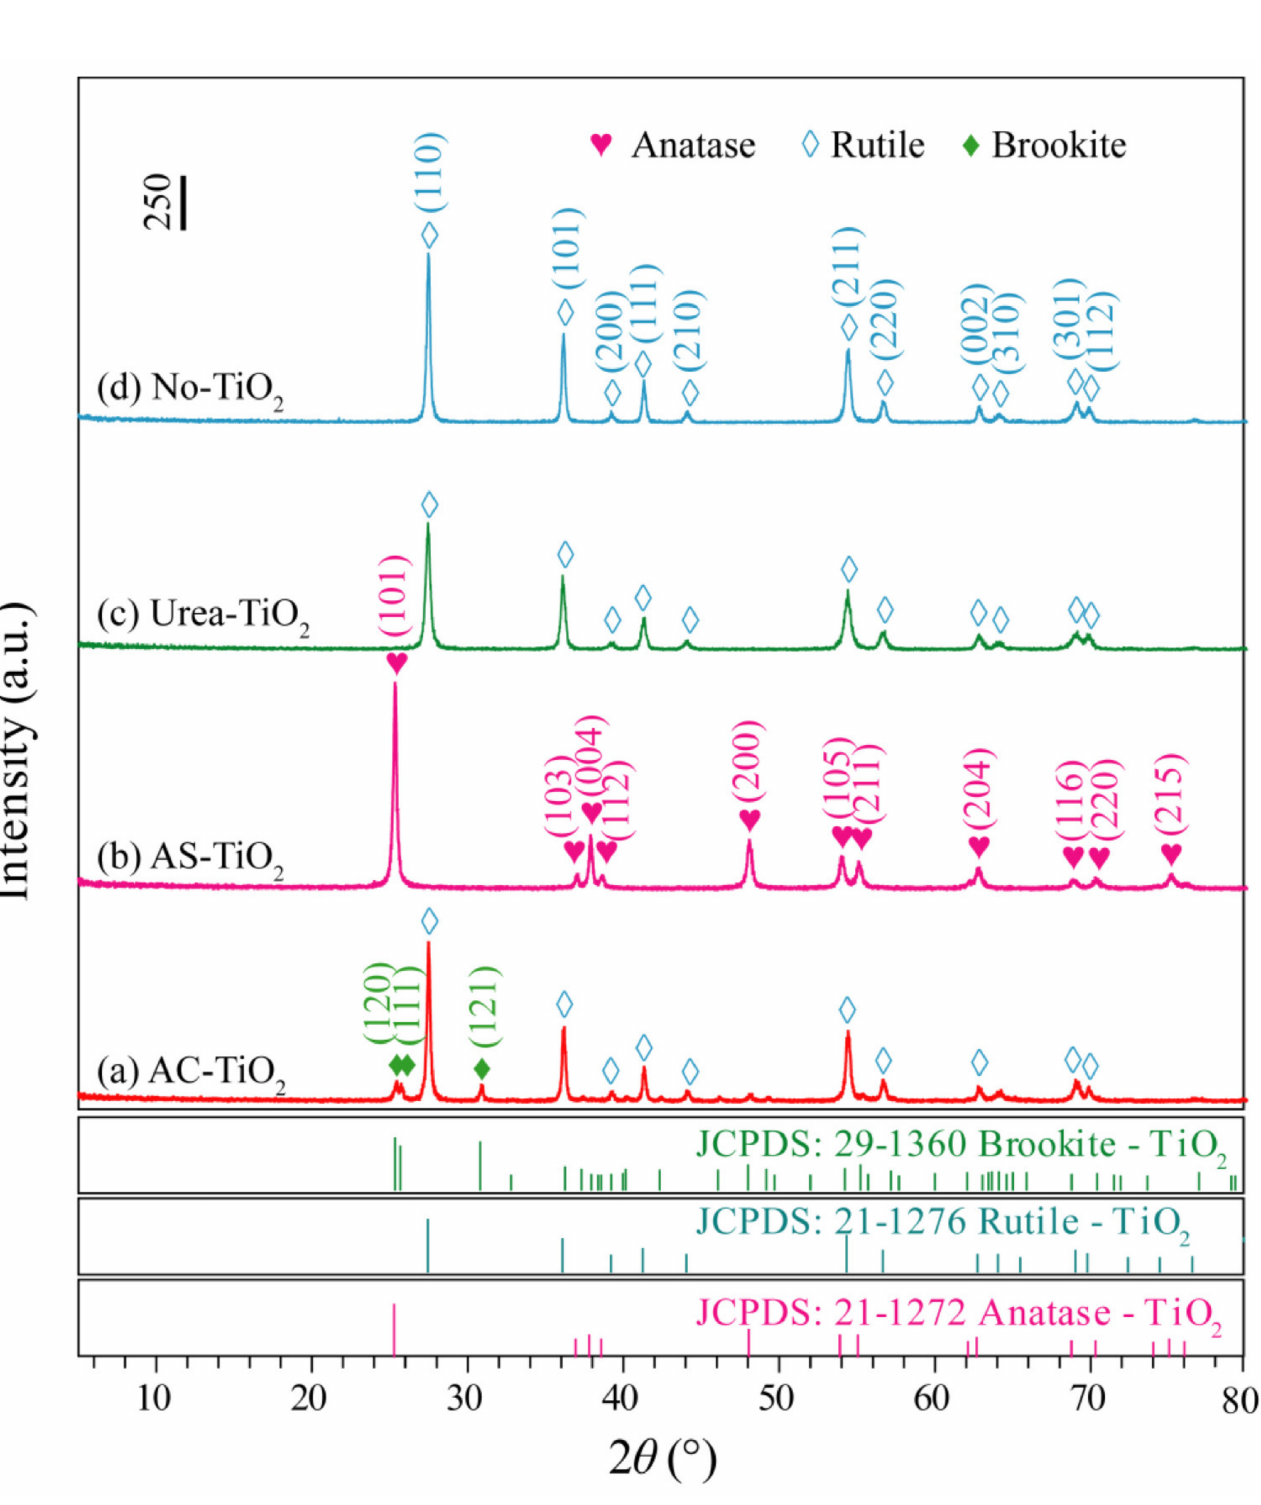
Figure 1. XRD patterns of as-prepared ( a ) AC-TiO 2 ; ( b ) AS-TiO 2 ; ( c ) urea-TiO 2 ; ( d ) No-TiO 2 micro- crystals in the presence and absence of shape-controlling